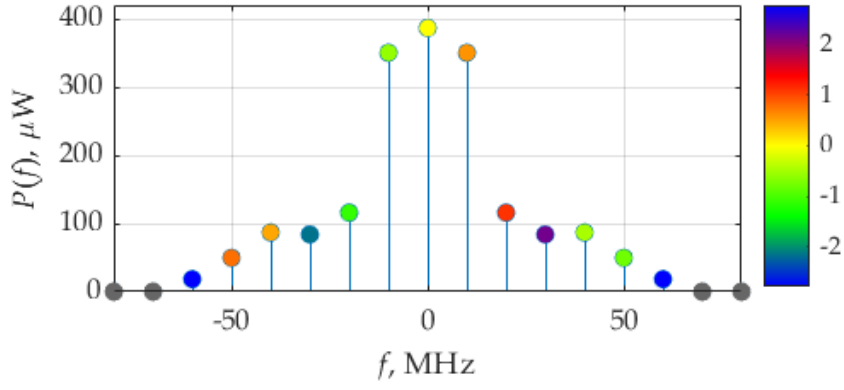
Figure 7. The spectrum of p ( t ) for the case of finite sum of harmonics current.